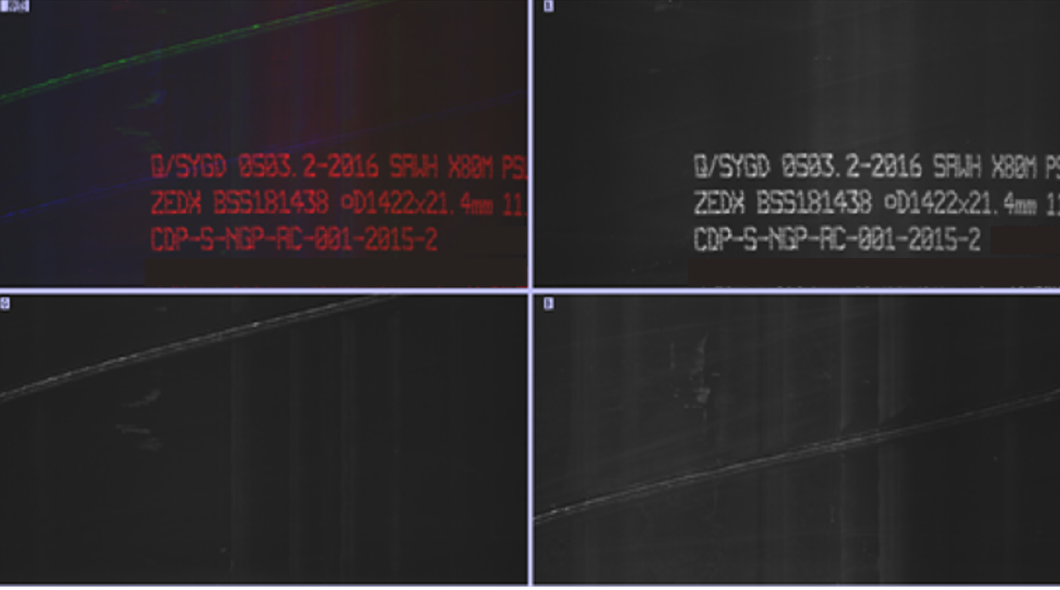
Figure 16. Captured information and scratch in